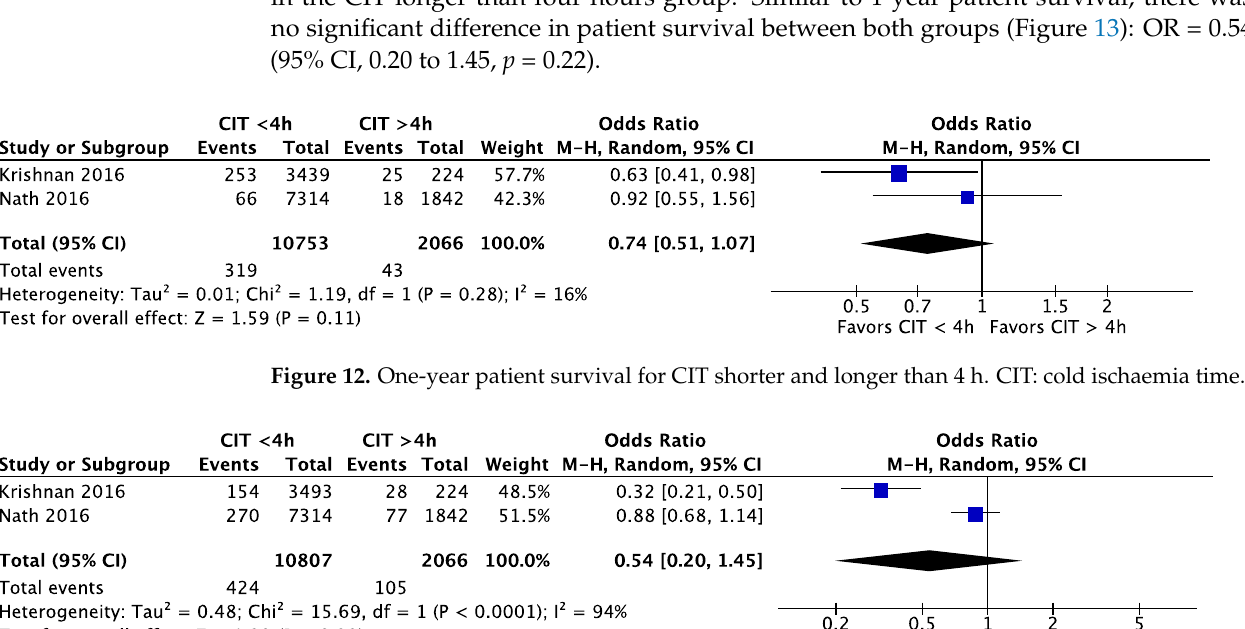
Figure 11. Ten-year graft survival for CIT shorter and longer than 4 h. CIT: cold ischaemia time.